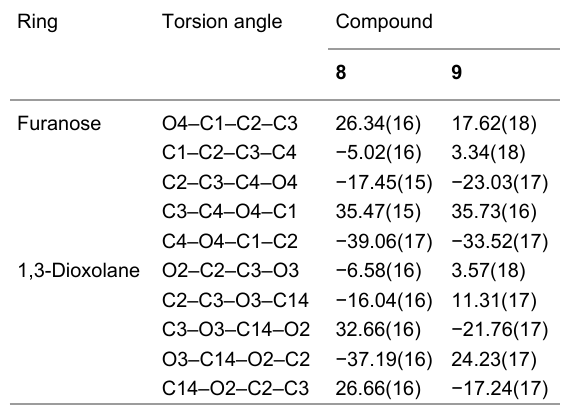
Table 6: Relevant torsion angles (°) a for the five-membered furanose ring and the five-membered 1,3-dioxolane ring in compounds 8 and 9 . Ring Torsion